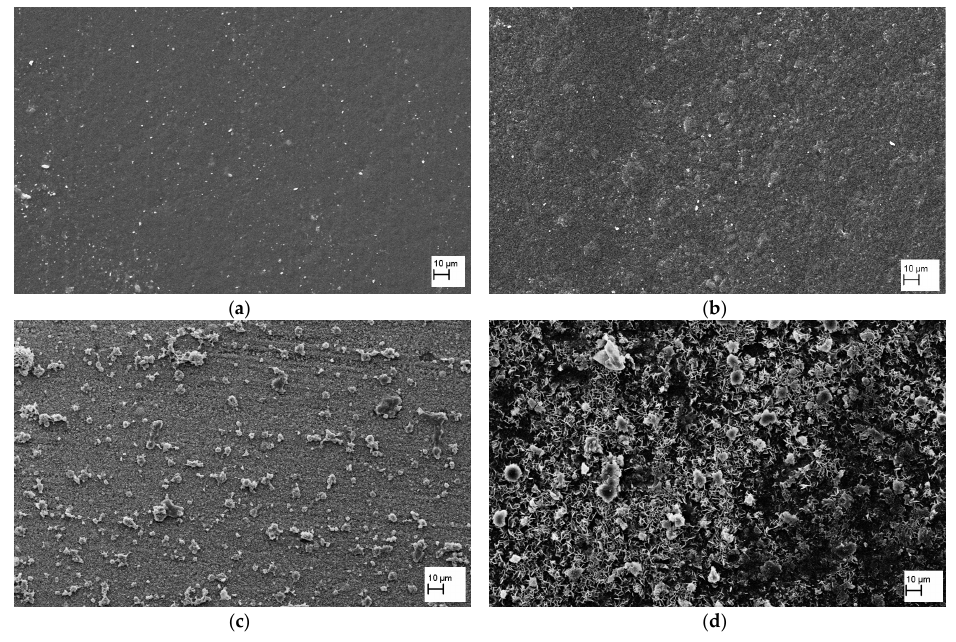
Figure 9. SEM images of PUR ( a ) and PUR-M ( b ) before calcification study and images of PUR ( c ) and PUR-M ( d ) after calcification study.